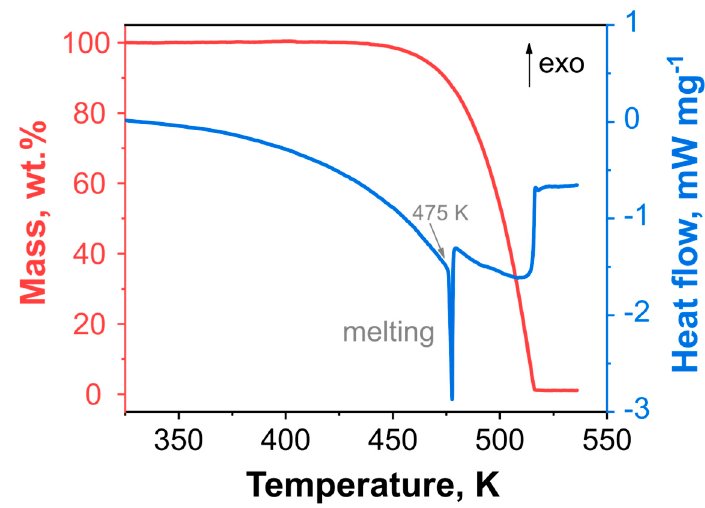
Figure 2. Thermal behavior of DBT under atmospheric pressure at the heating rate of 1 K min − 1 : the red trace is a thermogravimetry (TGA) curve, and the blue is the atmospheric pressure differential scanning calorimetry (DSC) curve, correspondingly.